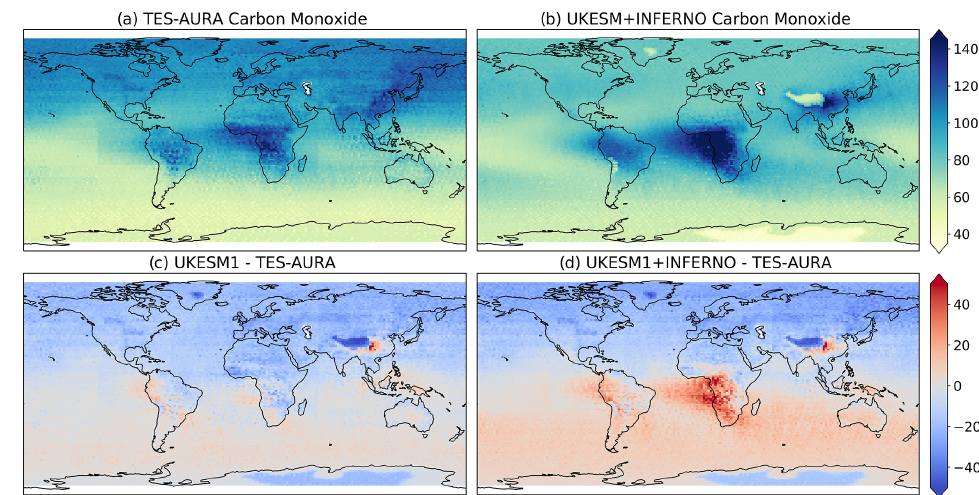
Figure 9. Column volume mixing ratio carbon monoxide (ppm) averaged between 700 and 300hPa over the period 2007–2012 for (a) TES-AURA satellite retrievals, (b) UKESM1+INFERNO, (c) difference between UKESM1 and TES-AURA, and (d) difference between UKESM1+INFERNO and TES-AURA.